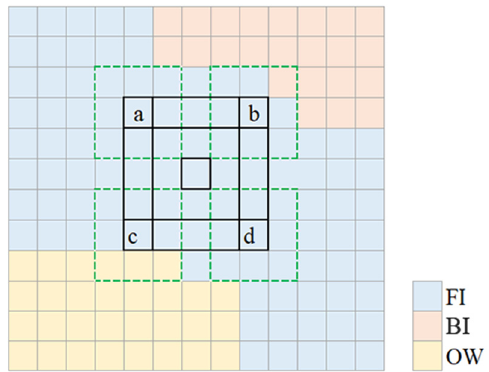
Figure 4. Example of an image segment with three surfaces (the different colors) and a labeled area from the floe ice (FI) surface. The dotted boxes represent the patches around the four labeled pixels “a”, “b”, “c”, and “d”.